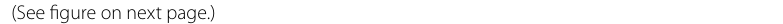
Fig. 2 Best-fit distribution models for each dataset (spring, fall, and combined) and their corresponding response curves for the set of covariates used to build each best-fit model. The two top-most response curves for each model represent the count (i.e., abundance) component of the zero-inflated model. The bottom-most response curve for each model is the probability of false zeroes as predicted by the environmental covariate used in the zero-component of the model. Estimates, standard errors (SE), and the p-values for each covariate used in the best-fit model are displayed on the response curve plots. All black dots represent a single abundance estimate for each 500